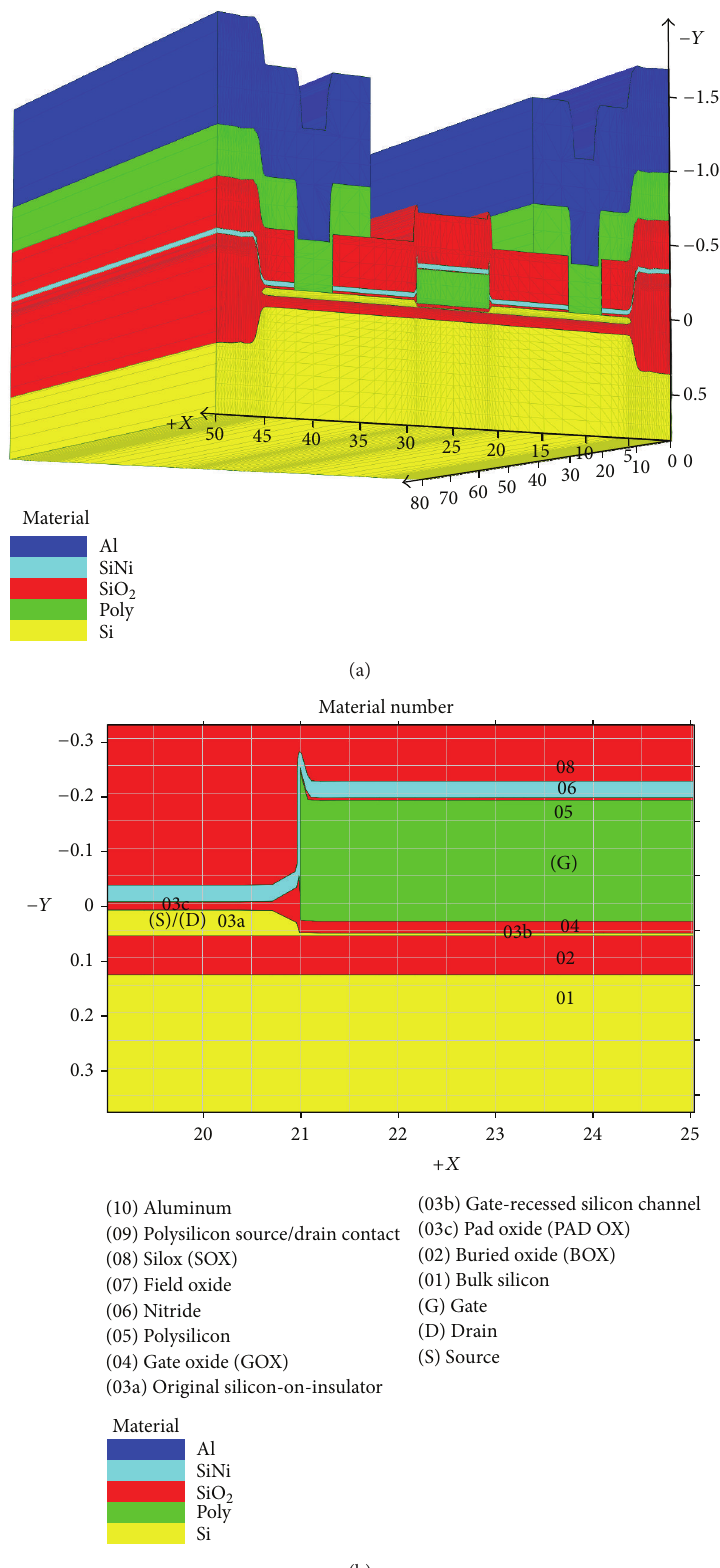
Figure 2: (a) 3D cross view and (b) 2D zoom-in of NSB device (4.6nm thick SOI channel), using TCAD process simulation. 𝑋 , 𝑌 , and 𝑍 axes are in micron